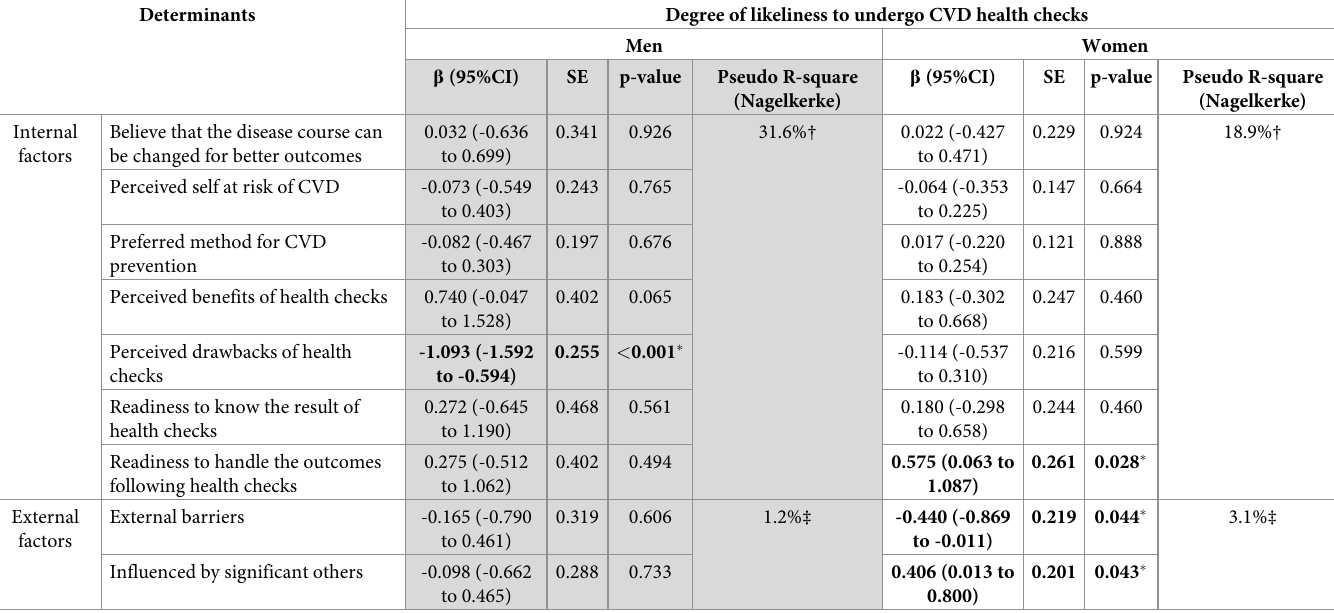
Table 3. Determinants of individuals’ degree of likeliness to undergo CVD health